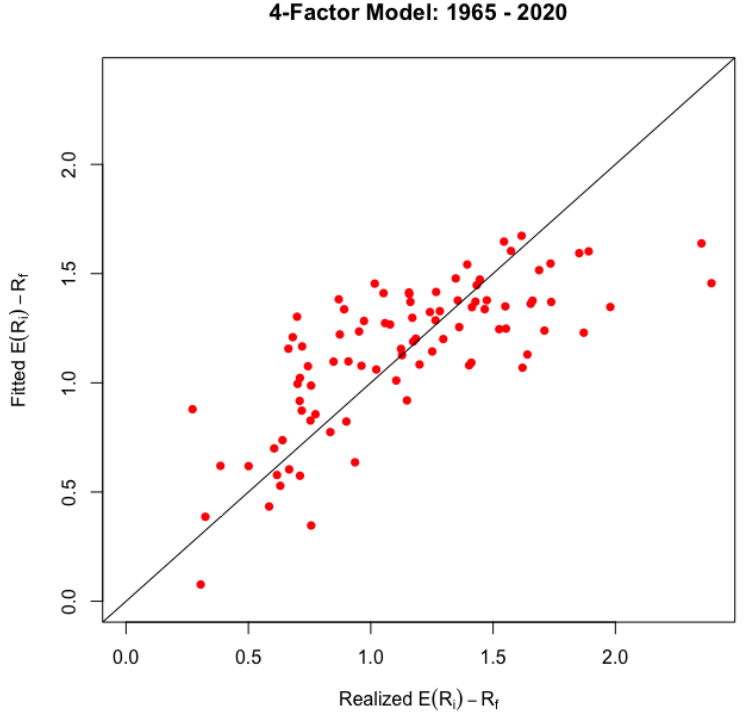
Figure 9. Out-of-sample cross-sectional relationships for the Fama and French four-factor model between average one-month-ahead fitted (predicted) excess returns in percent ( y -axis) and average one-month-ahead realized excess returns in percent ( x -axis): January 1965 to December